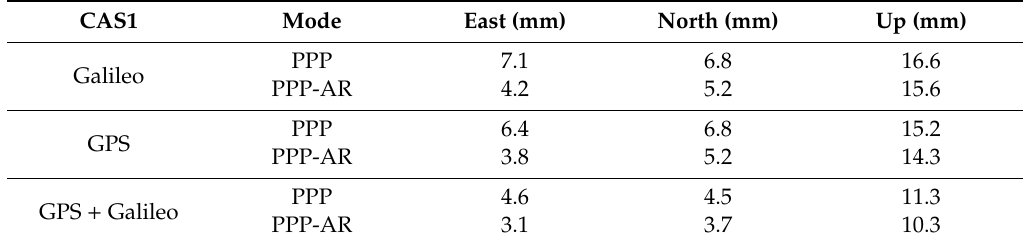
Table 5. 1- σ values PPP and PPP-AR for CAS1 station.